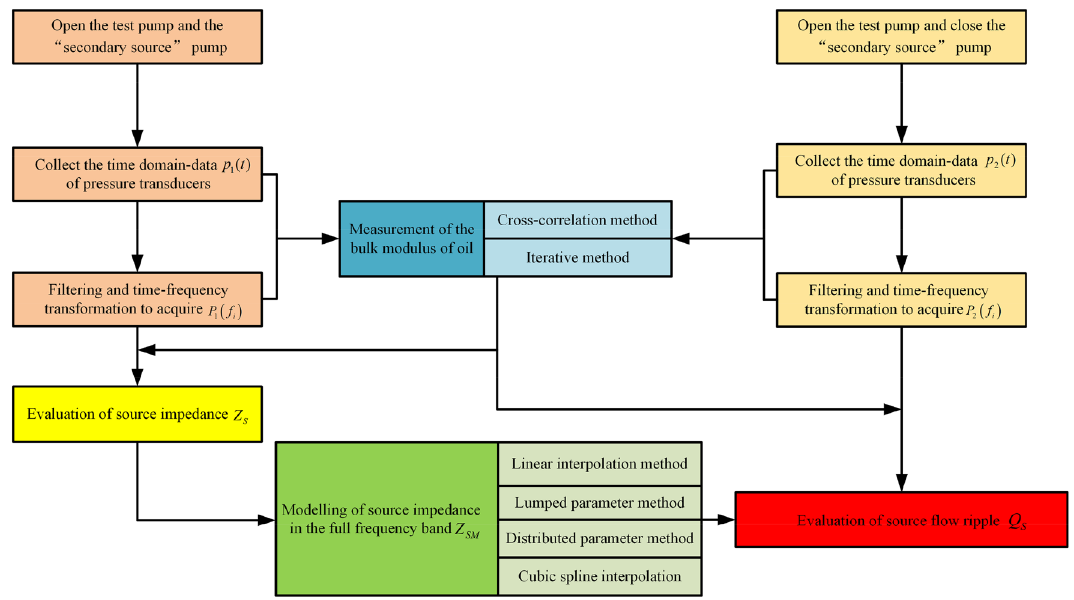
Figure 26. Testing process and data processing flow chart of the secondary source